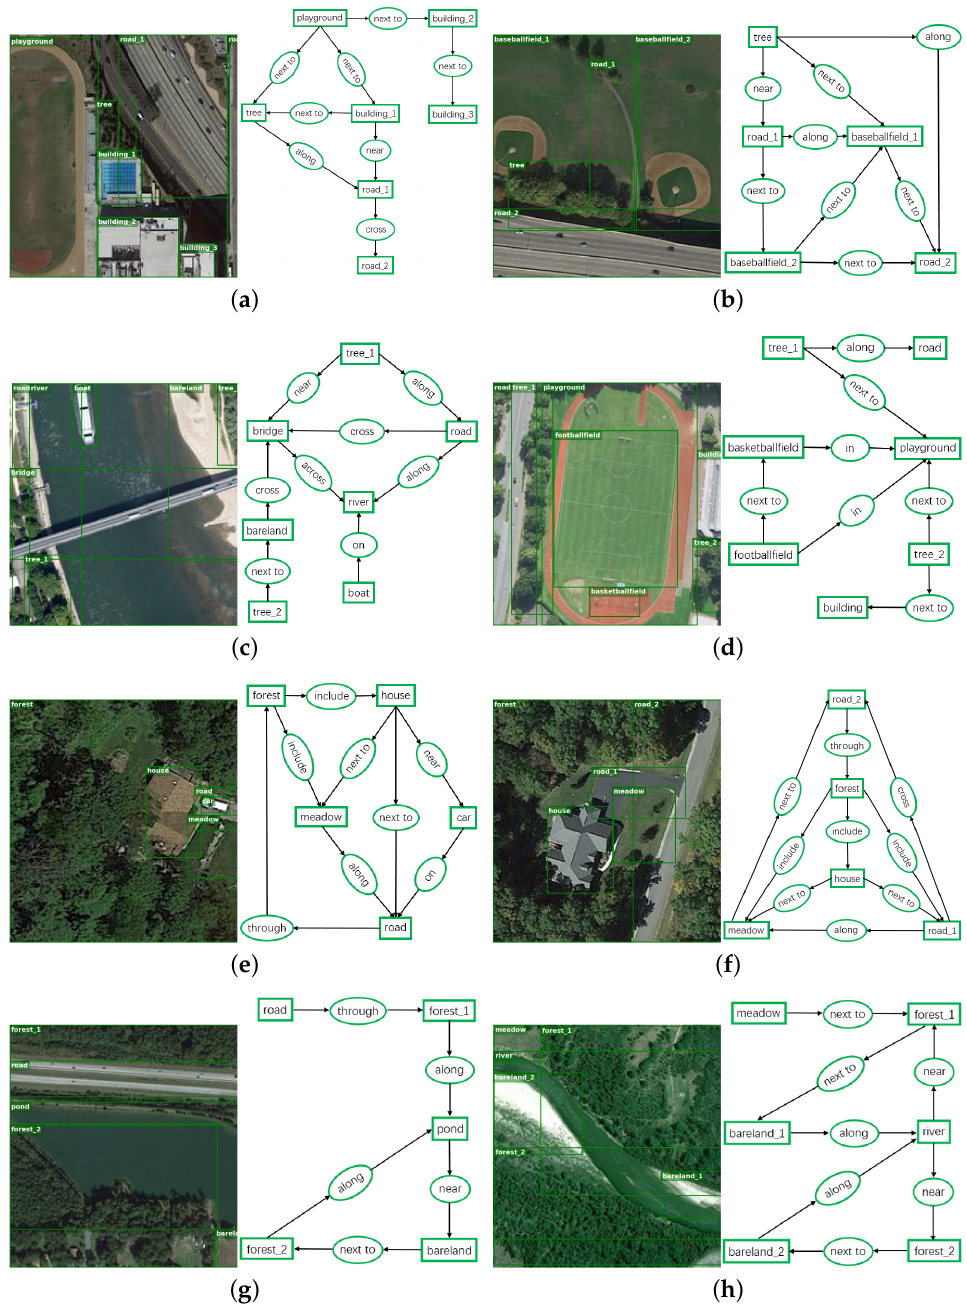
Figure 12. The ground-truth visualization on RSSGD. From ( a – h ) are the annotations of object detection ( left ) and scene graph generation ( right ) corresponding to Figure 11, which not only covers artificial scenes such as baseballfield and residential area, but also includes natural scenes such as river and